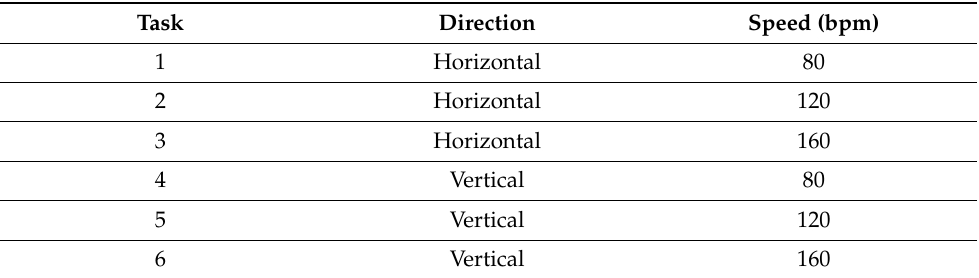
Table 3. Exercise attributes used in the